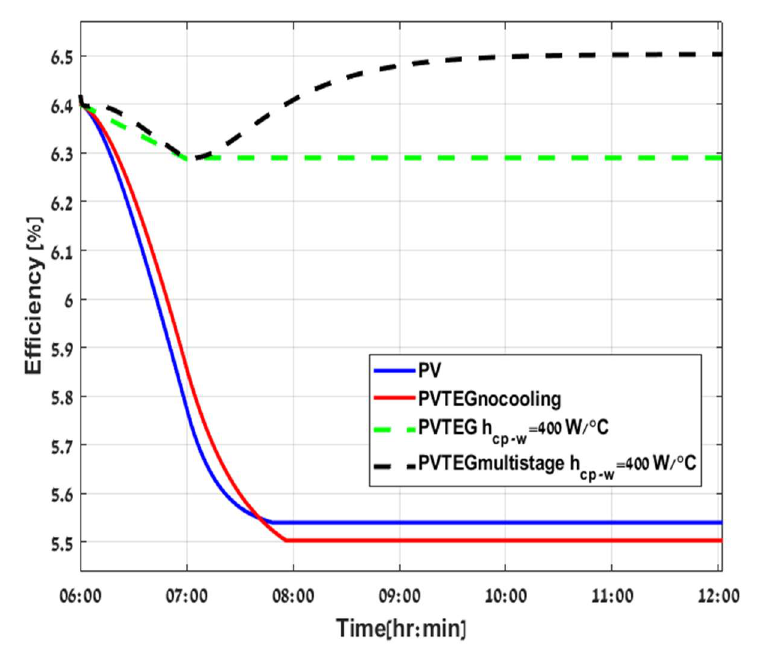
Figure 12. Configuration of PV stand-alone (blue, continuous line), PVTEG without cooling (red, continuous line), PVTEG (green dashed line), and PV Multistage TEG (black dashed line).